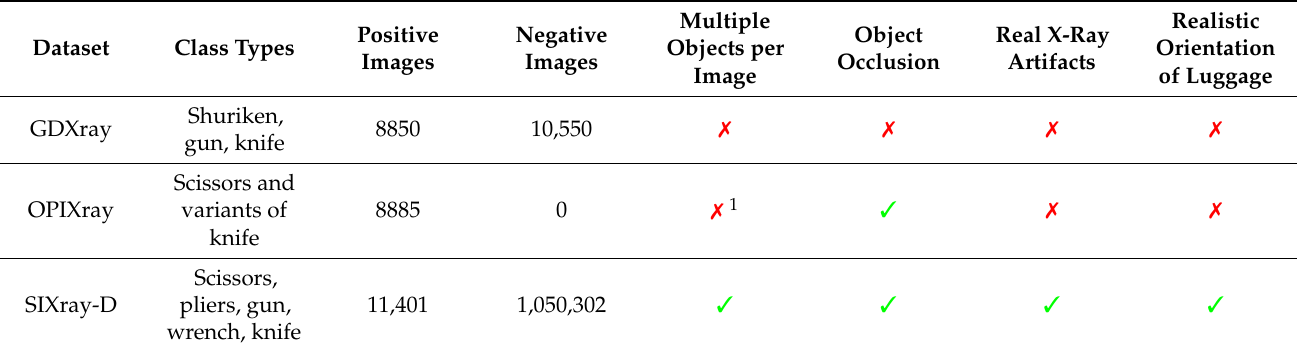
Table 1. Key attributes of popular detection security X-ray datasets, namely GDXray [14] and OPIXray [13], as well as the proposed SIXray-D